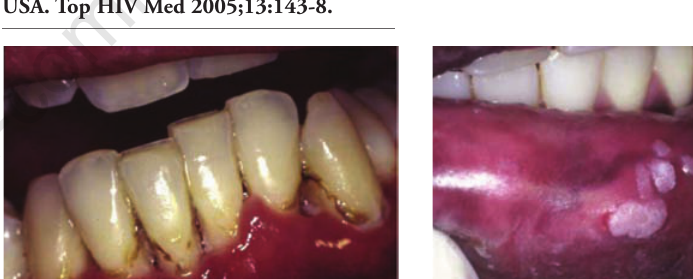
USA. Top HIV Med 2005;13:143-8.